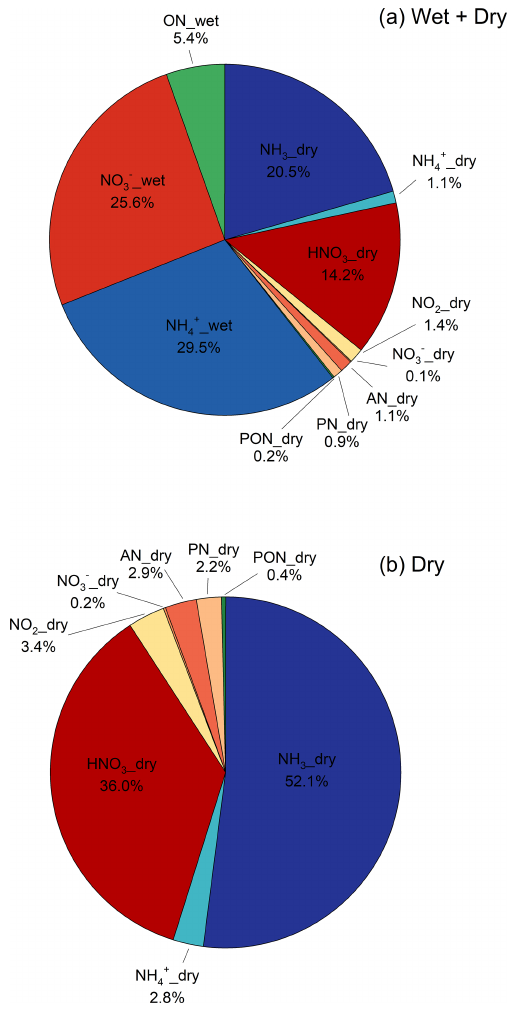
Figure 11. Speciated annual total (wet and dry) (a) and dry (b) deposition showing the percent contribution of individual compo-